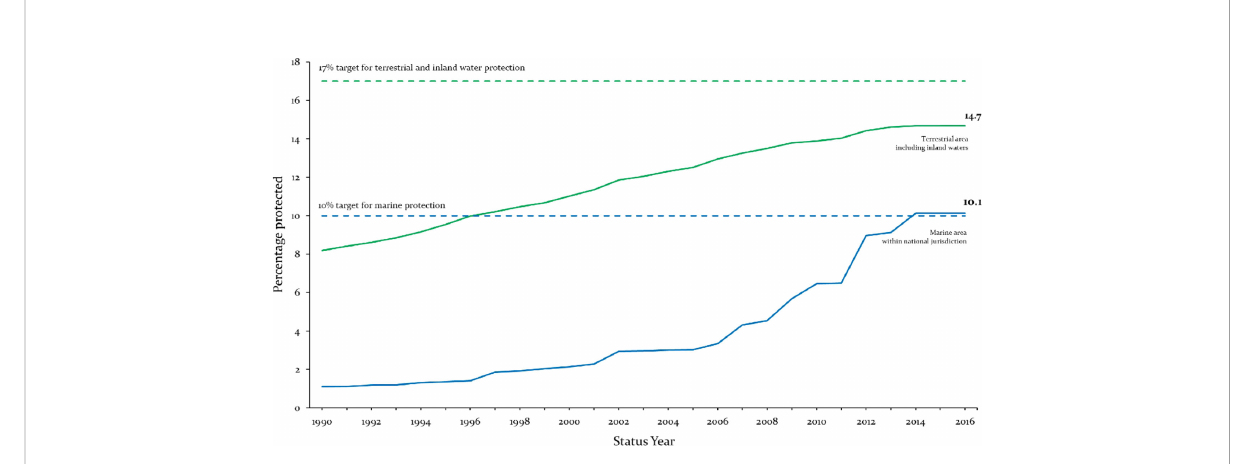
FIGURE 11 Growth of the global protected area network since 1990 [source: UNEP-WCMC and IUCN 2016 as cited in UNEP-WCMC